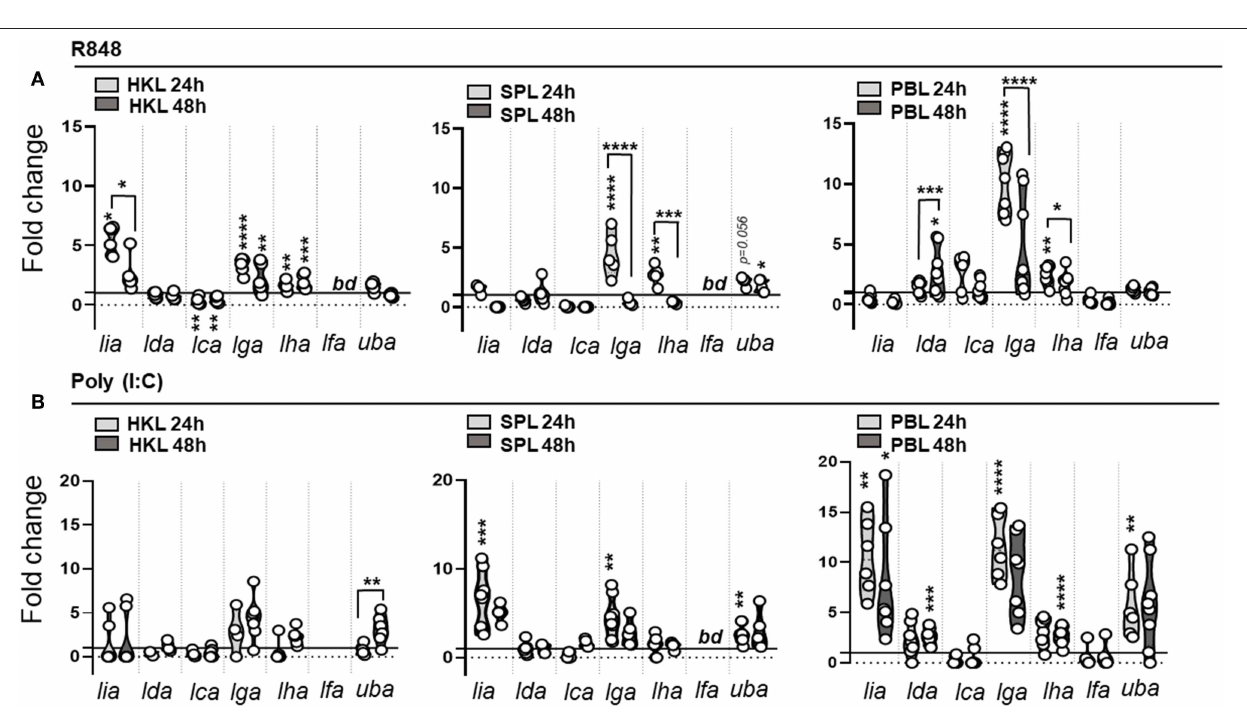
FIGURE 7 | MHC class I L lineage mRNA induction in response to viral associated PAMPs in primary leucocytes. Expression of MHC class I L lineage ( lia, lda, lca, lga, lha, and lfa ) and classical MHC class I ( uba ) in HKL, SPL, and PBL stimulated with (A) 2 µ g R848 and (B) 10 µ g Poly (I:C) for 24h (light gray) and 48h (dark gray Gene expression data at each time point were normalized against the reference gene EF1 α B and fold changes were calculated using the unstimulated sample (media alone) at the same time point. The data represent values from [ n ǫ (6;8)] individuals, with each dot representing cells isolated from an individual fish. The line intersecting the y-axis at 1 represents the unstimulated control that the fold change of the treatments is in relation to. Asterisks above each violin plot indicates the strength of significance: * p < 0.05, ** p < 0.01, *** p < 0.001, and **** p < 0.0001. bd , below